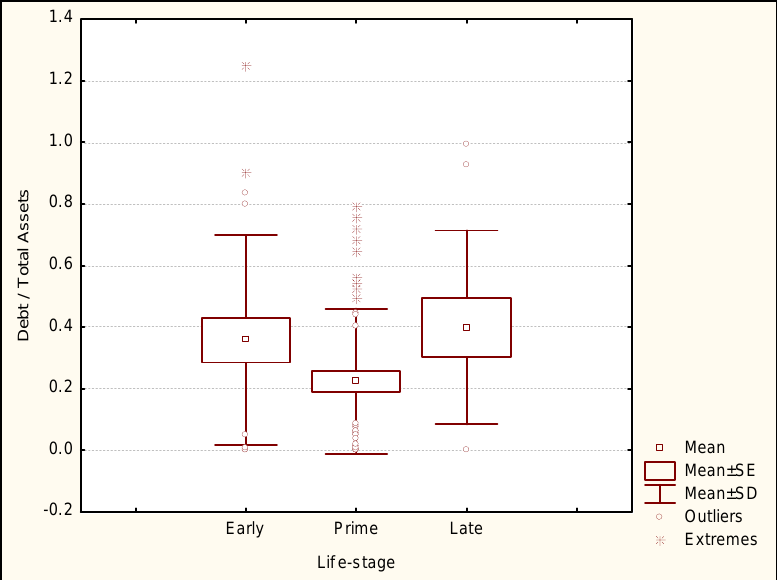
Figure 2: Box and whisker plot of three stage life stage classification to debt/total assets